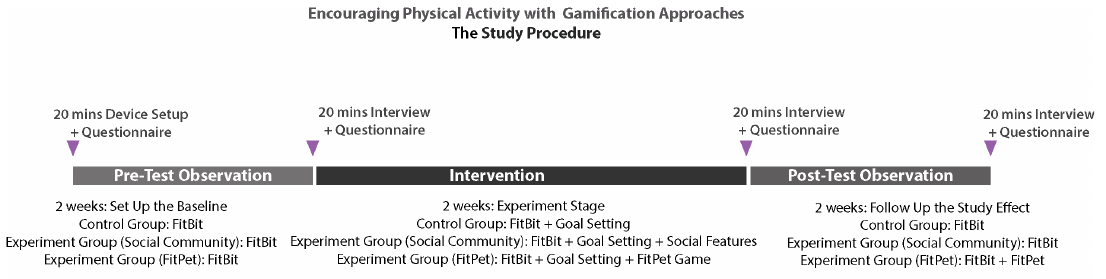
Figure 4 . The Six-week Field Study Timeline